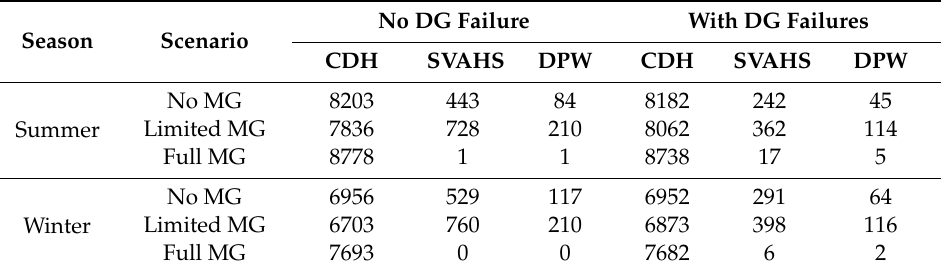
Table 16. Mean diesel fuel consumption (gallons) of the system without CDH PV in 7 days outages.